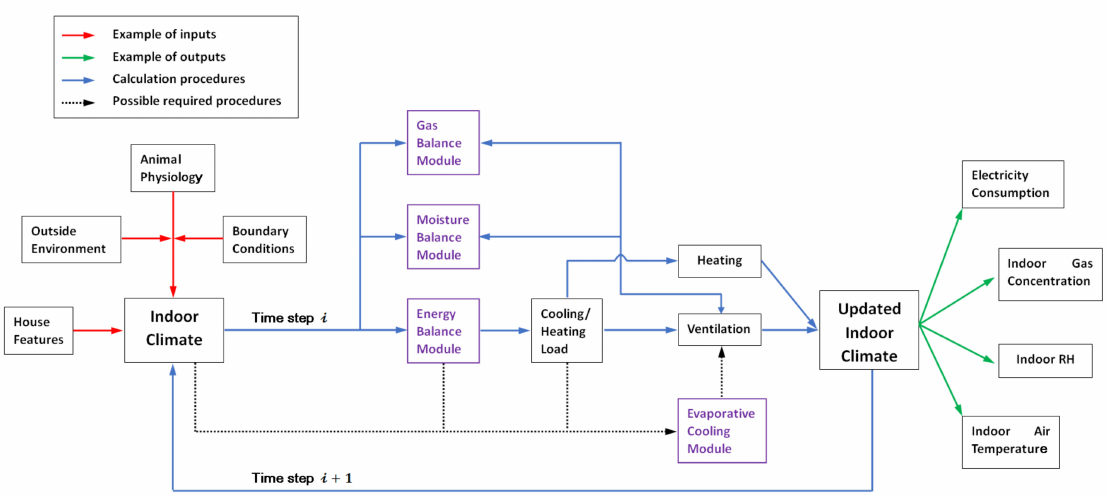
Figure 2. The flowchart of the customized model showing the key modules and simulation procedures.